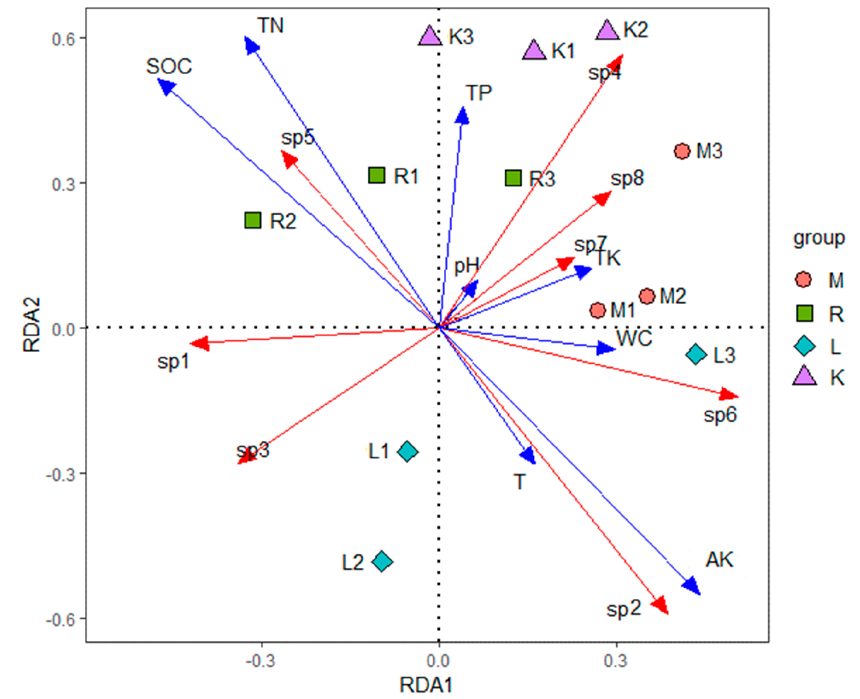
Figure 6. Redundancy analysis of bacterial community and soil environmental factors. Notes: sp1, sp2, sp3, sp4, sp5, sp6, sp7, and sp8 stand for alphaproteobacteria, actinobacteria, betaproteobacteria, subgroup_6, gammaproteobacteria, thermoleophilia, planctomycetacia, and gemmatimonadetes. Red line stands bacterial community, blue line stands soil environmental factors.